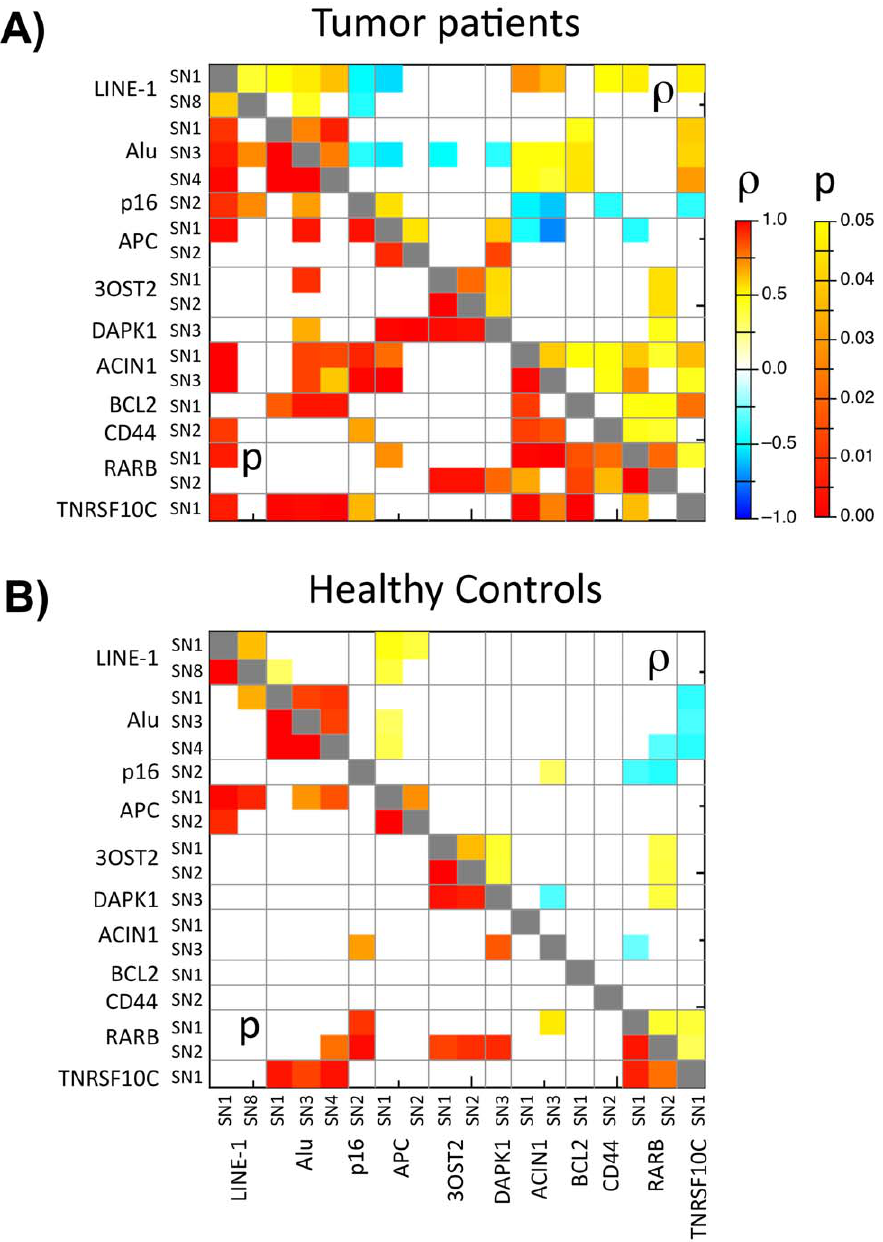
Figure 3. Heatmap showing p values (lower left triangle) and significant Spearman correlation coefficient ( r : upper right triangle) between methylation levels at different CpGs in peripheral blood of pancreatic cancer patients (A) and control group (B) (p values of . 0.05 are in white, the shown r -values are corresponding to p values , 0.05).